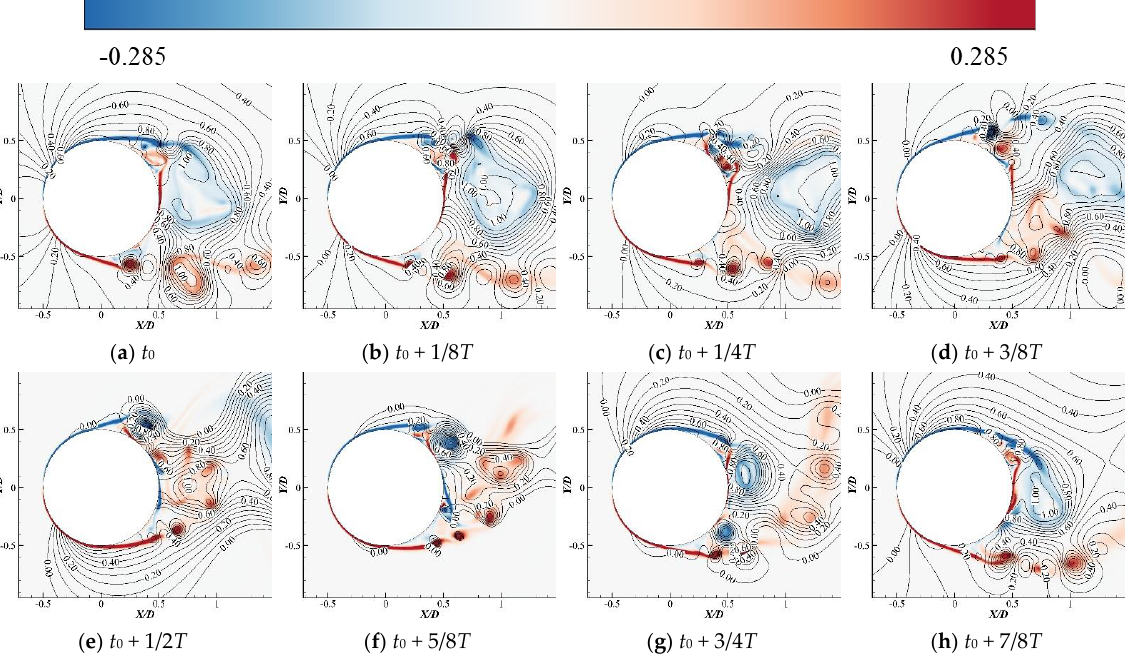
Figure 5. Evolutions of the cavitating vortices and the pressure in a quasiperiod at σ = 2.92.